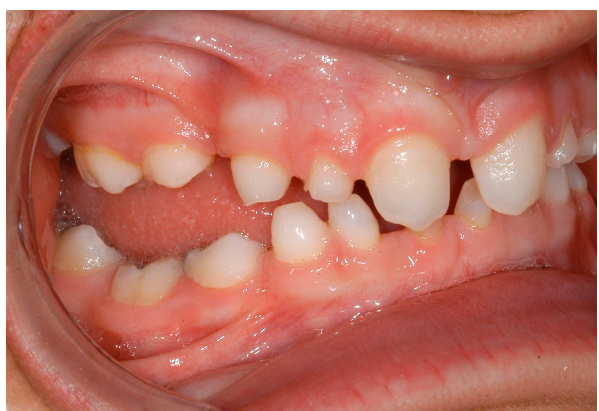
Figure 6. Intraoral situation: oligodontia, microdontia of teeth 11 and 21 and a pronounced lateral open bite.